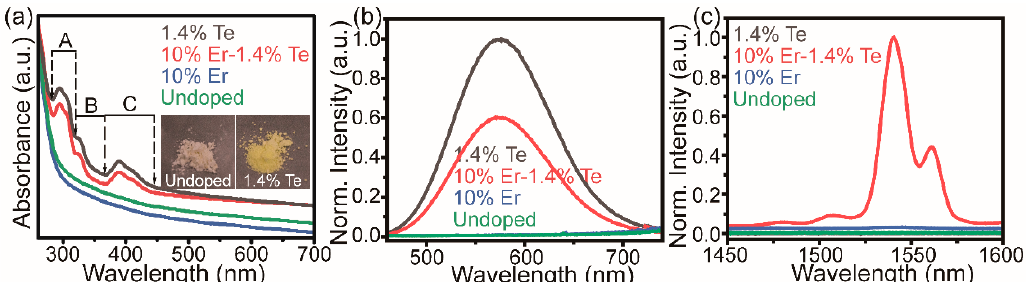
Figure 2. ( a ) UV–Vis absorption spectra of undoped, Er 3+ -doped, Te 4+ -doped, and Te 4+ /Er 3+ -co-doped Cs 2 SnCl 6 microcrystals. The inset shows photographs of undoped and Te 4+ -doped Cs 2 SnCl 6 microcrystals. Normalized PL spectra ( λ ex = 391 nm) of undoped, Er 3+ -doped, Te 4+ -doped and Te 4+ /Er 3+ -co-doped Cs 2 SnCl 6 microcrystals ( b ) in the visible region and ( c ) in the NIR region.